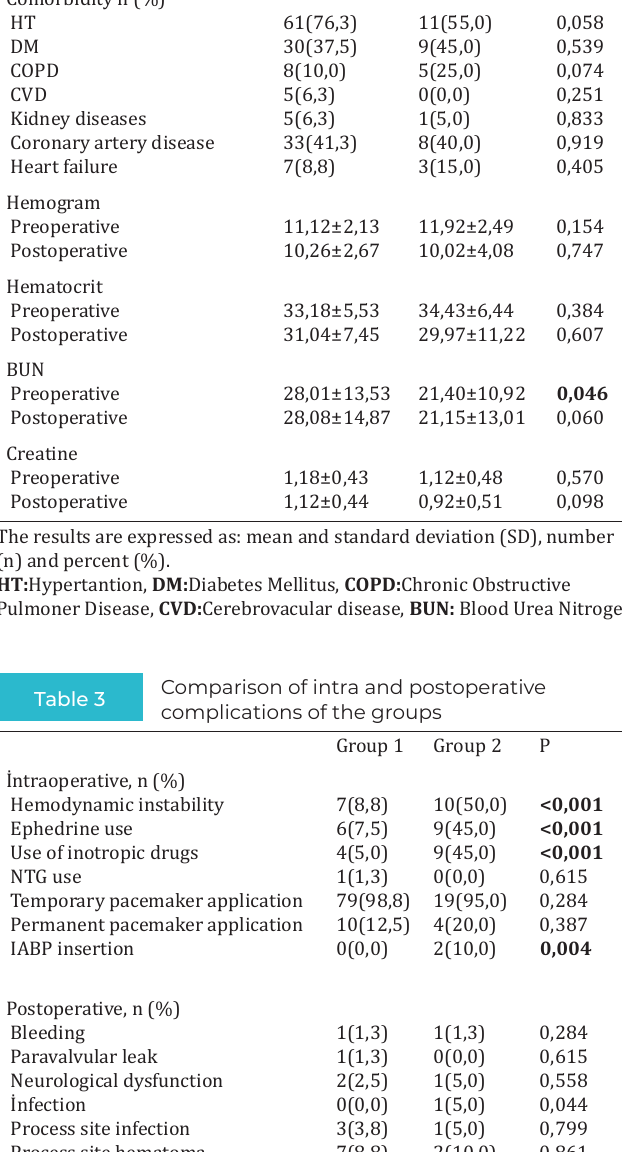
The results are expressed as: number (n) and percent (%). NTG: Nitroglycerin, IABP: İntraaortic Balloon